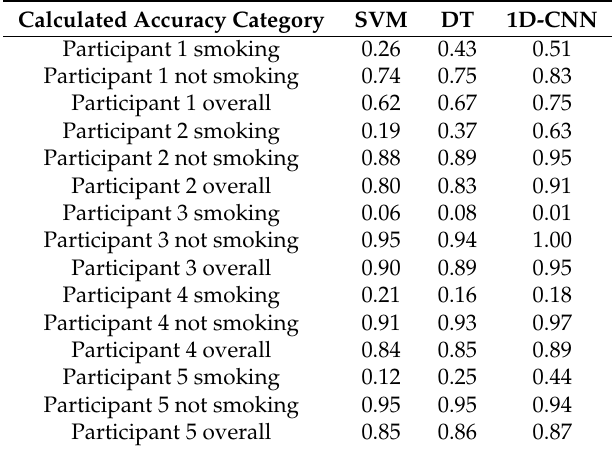
Table 3. The average accuracy based on only 3 accelerometer values.